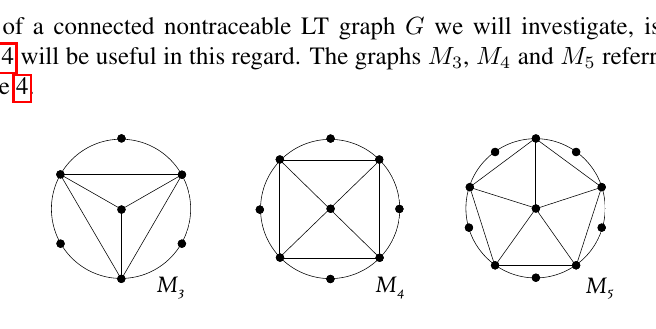
Fig. 4: The graphs M 3 , M 4 and M 5